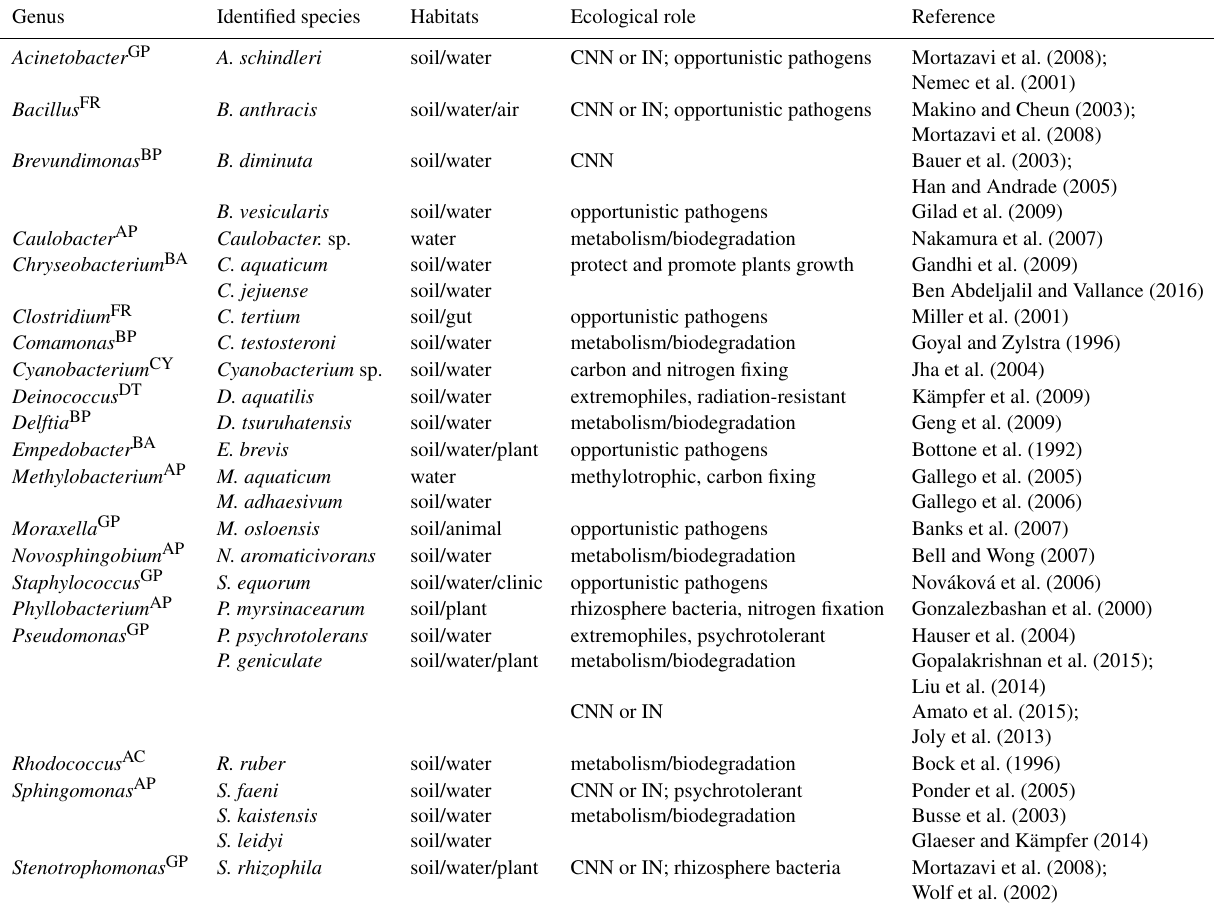
Table 3. The identified bacterial species in cloud water samples correlated with the potential ecological